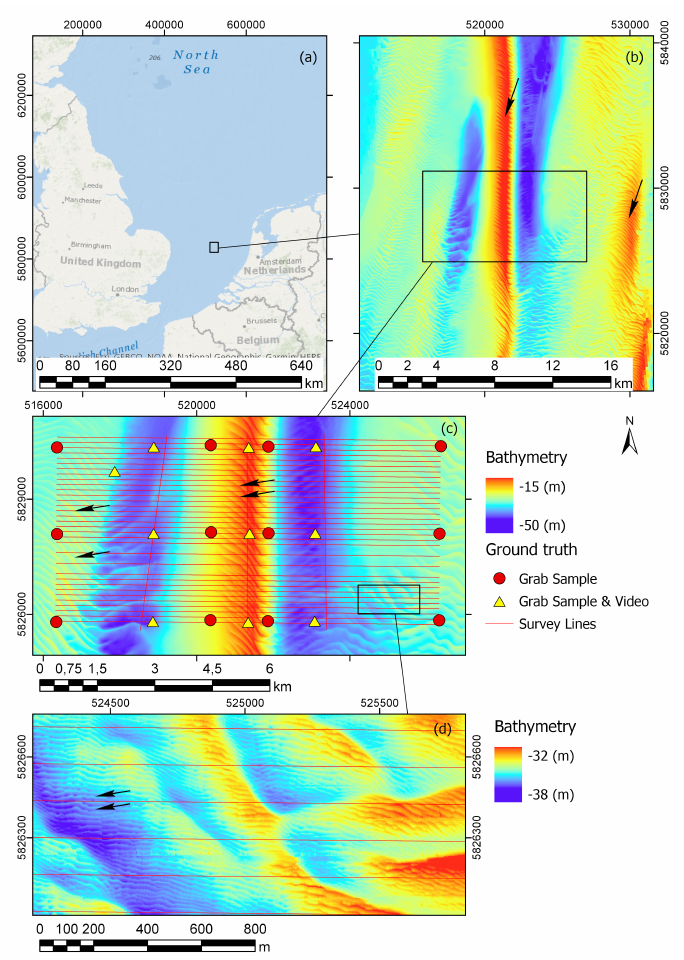
Figure 1. ( a ) Location of Brown Bank area in North Sea (data source: [16]); ( b ) Bathymetry of Brown Bank; arrows indicate sand banks; ( c ) Survey area; red circles and yellow triangles are ground truthing locations, survey lines are in red, and arrows point to sand wave structures (spatial resolution 1 m × 1 m); ( d ) Megaripple bed forms, indicated by arrows (spatial resolution is 1 m × 1 m, all depths are given in meters